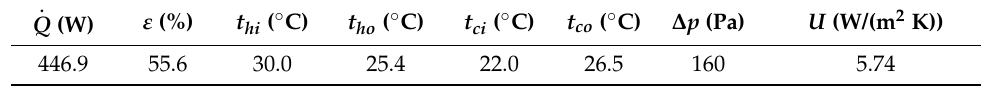
Figure 25. Final heat pipe heat exchanger arrangement. Table 4. Final HPHE working parameters for typical summer conditions.